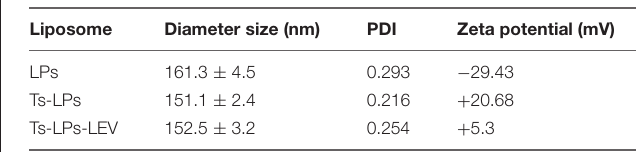
TABLE 2 | Liposome properties by ZetasizerNano ZS